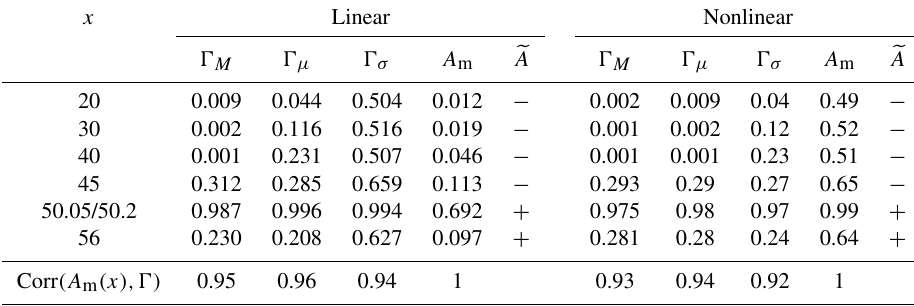
Table 1. Measure of the local coherence of the dispersive focusing wave. x Linear Nonlinear (cid:48) M (cid:48) µ (cid:48) σ A m 20